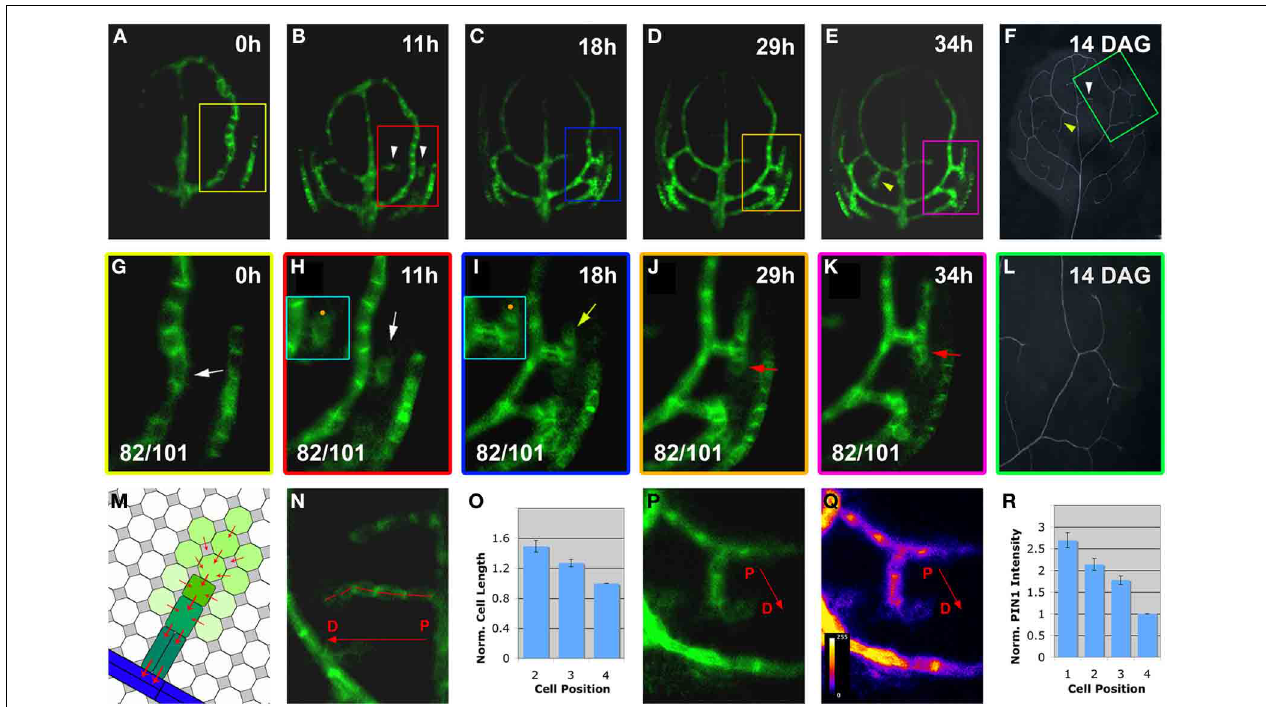
FIGURE 2 | Live-imaging of hPED initiation and extension. Top right, time after first imaging time point ( t = 0; A–E , G–K ) or DAG (F,L) . Bottom left, reproducibility quotient ( Table 2 ). Scale bars: (A–E) 20 µ m; (F,L) 1mm; (G–K,N–Q) 10 µ m. (A–F) PIN1:GFP expression in a first leaf from 3 to